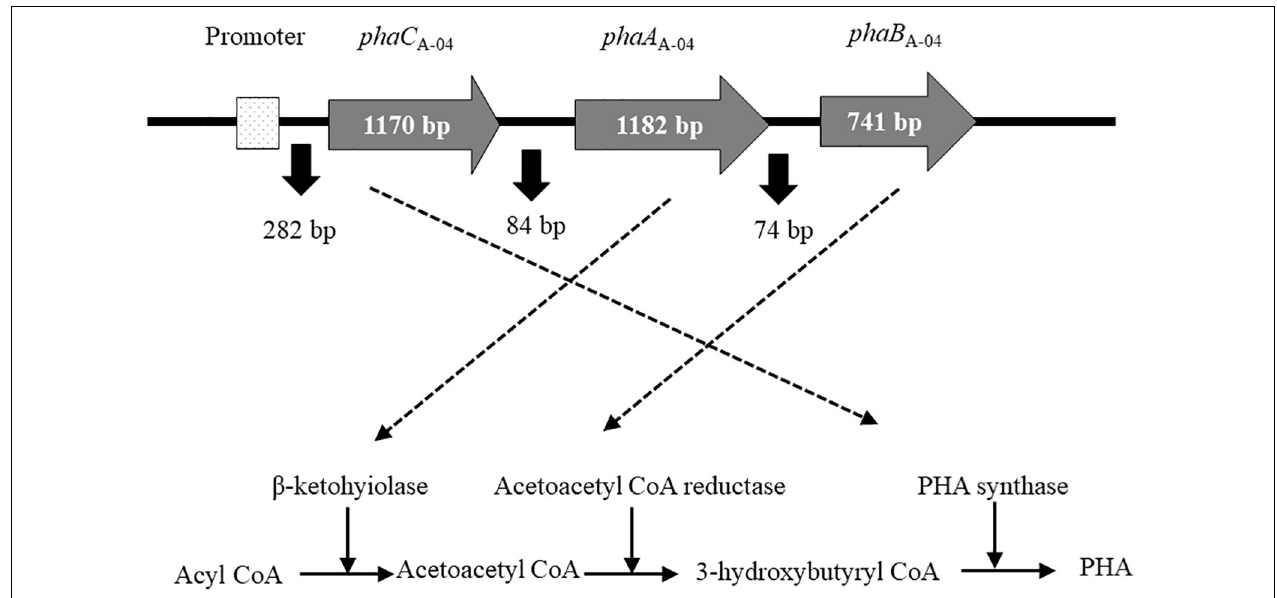
FIGURE 2 | Diagram of the molecular organization of phaCAB A - 04 biosynthesis genes from C. necator strain A-04. PHA synthase ( phaC A - 04 ), acetyl-CoA acetyltransferase ( phaA A - 04 ), acetoacetyl-CoA reductase ( phaB A - 04 ) genes and promoter (P A - 04